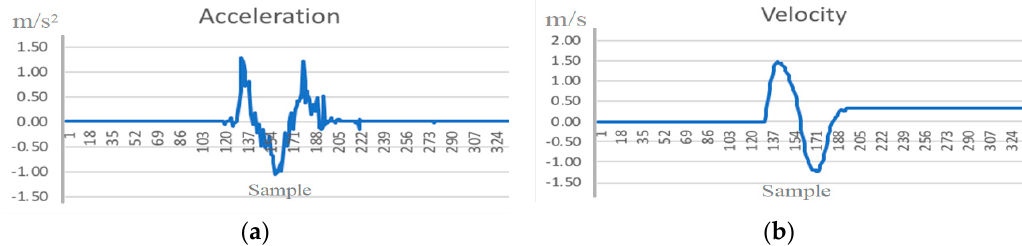
Figure 3. ( a ) The acceleration data obtained from the IMU sensor; ( b ) the corresponding velocity data, which was calculated by the complementary Kalman-based filter.